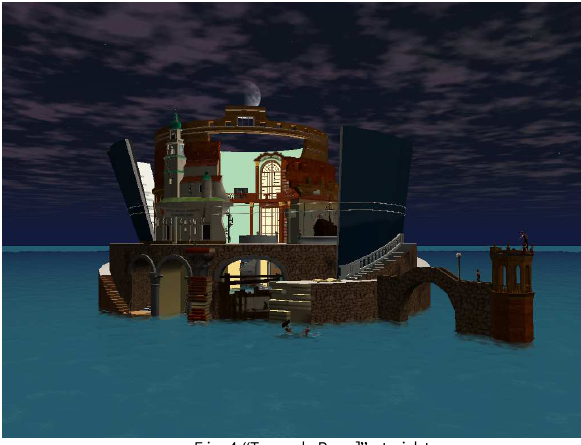
Fig. 2 “ O lápis de Tróia ”.